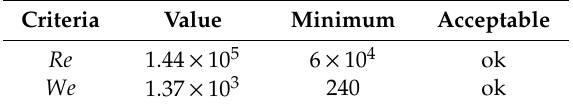
Table 1. Calculated Reynolds number and Weber number at the suction